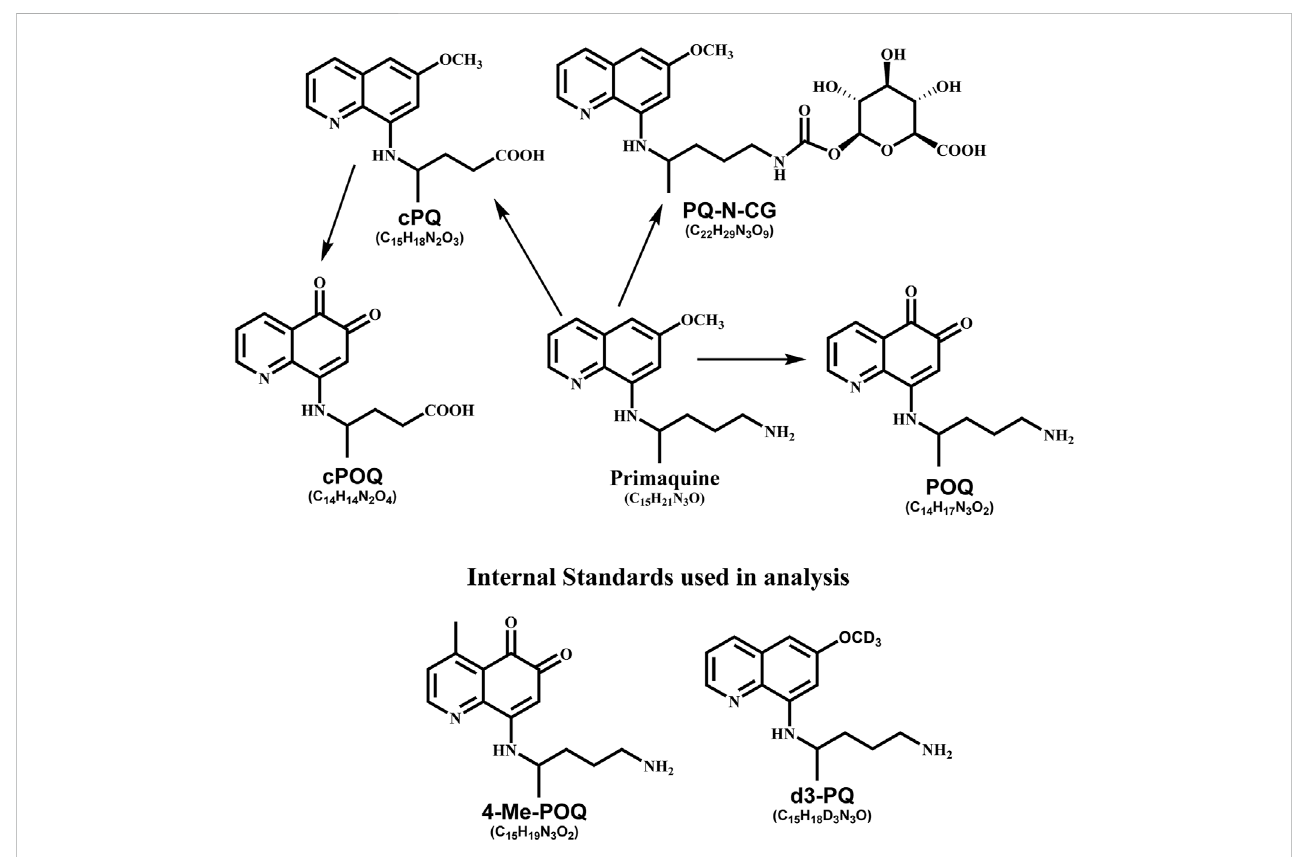
Chemical structure of analyte used in this